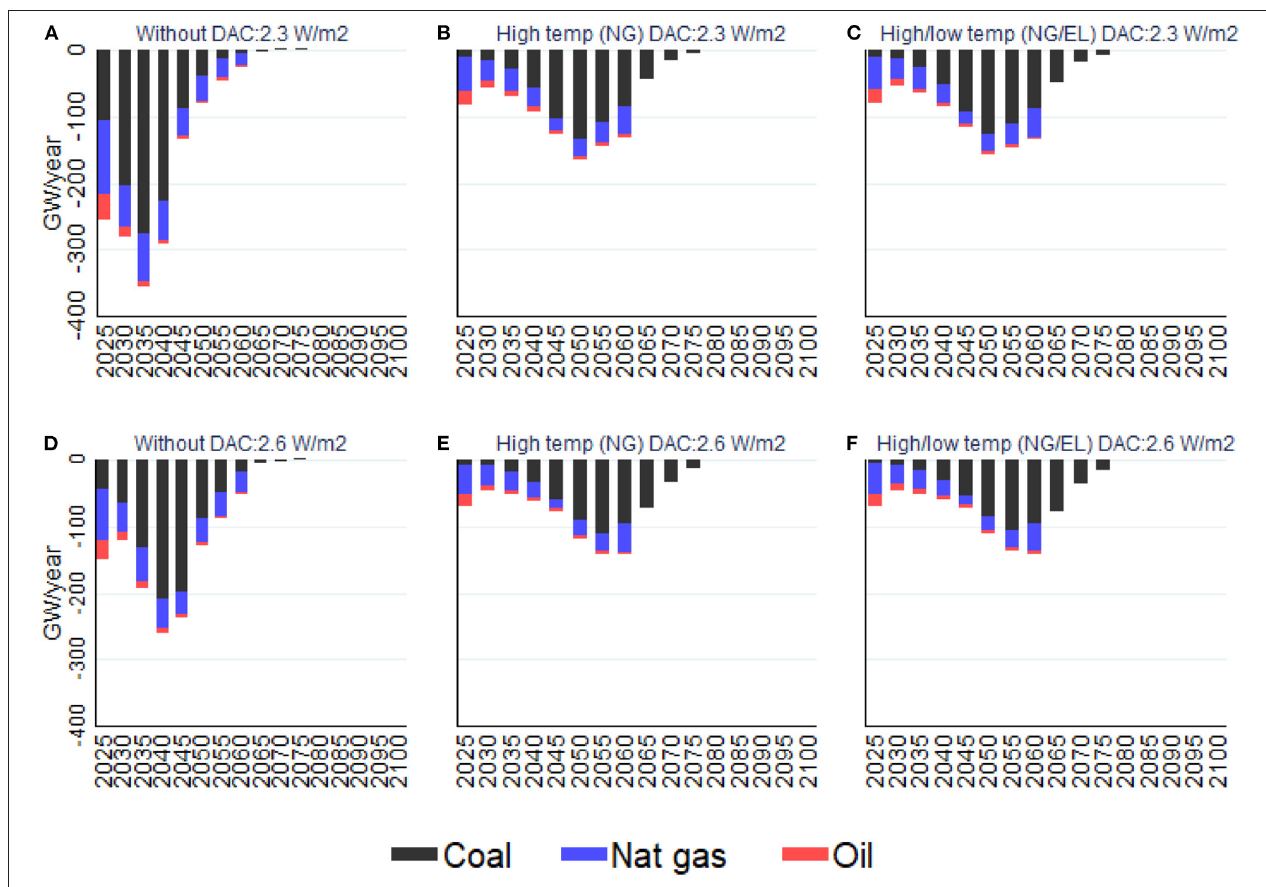
FIGURE 6 | Stranded capacities in the existing power plant types in the global power sector under the least cost strategy scenarios that aim to achieve climate mitigation by limiting total radiative forcing to 2.3 and 2.6 W/m 2 by year 2100, respectively. The scenario “Without DAC” includes only BECCS and AR, the scenario “High temp (NG) DAC” includes a high temperature natural gas-based DAC in addition to BECCS and AR, and the scenario “High/low temp (NG/EL) DAC” includes three types of DAC (high temperature natural gas-based DAC, high temperature electricity-based DAC and low temperature electricity-based DAC) in addition to BECCS and